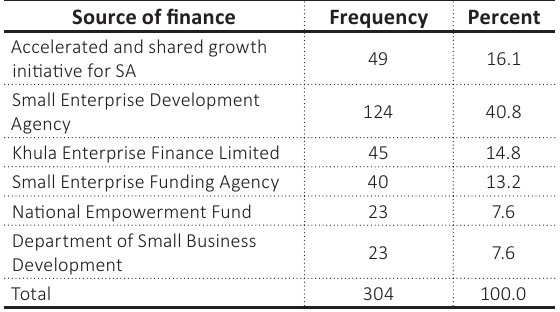
Table 1. Availability of the following source of finance for